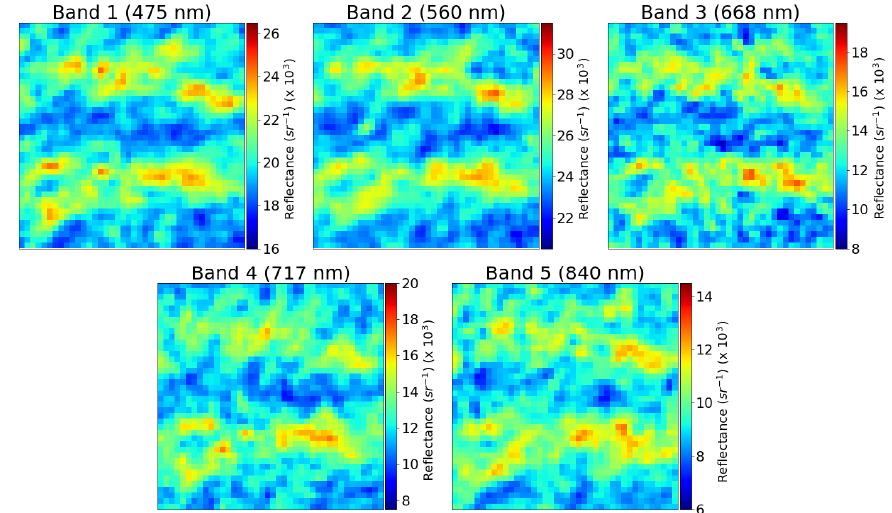
Figure 1. A subset of a multispectral image acquired in a coastal area of Korea targeted on the ocean surface with normal states (low chlorophyll and suspended particle concentration), showing the differences in the spatial pattern for the five spectral bands.